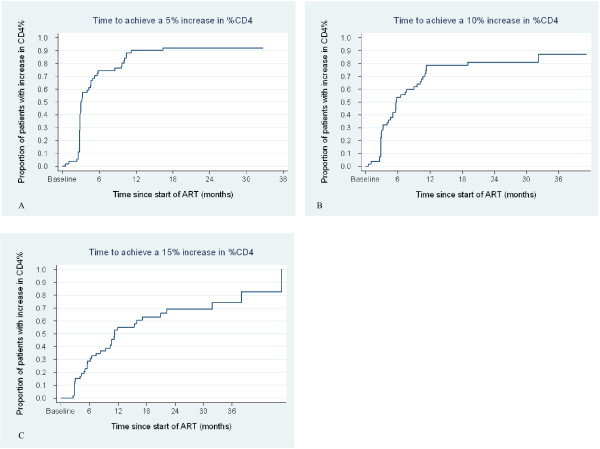
Kaplan Meier plots for increase in CD4% from baseline among HIV-1 infected children. Kaplan Meier survival curves of increase in CD4% from baseline with time with plots A, B and C showing time to (A) 5%, (B) 10% and (C) 15% increase in CD4% from baseline.